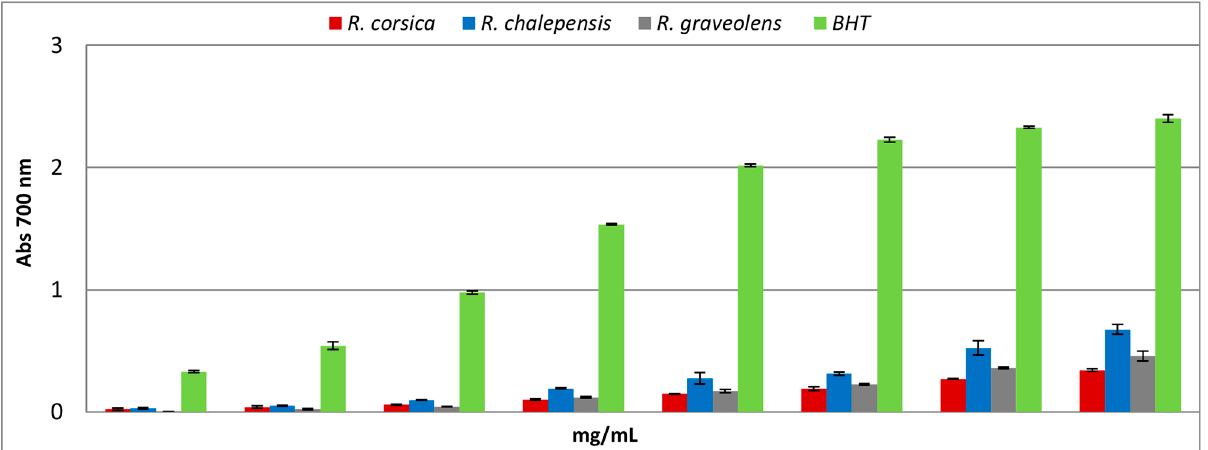
Figure 5. Reducing power of the methanolic extracts of the Ruta spp. in vitro cultured biomass, evaluated by spectrophotometric detection of Fe 3+ -Fe 2+ transformation. Values are expressed as the mean ± SD ( n = 3).